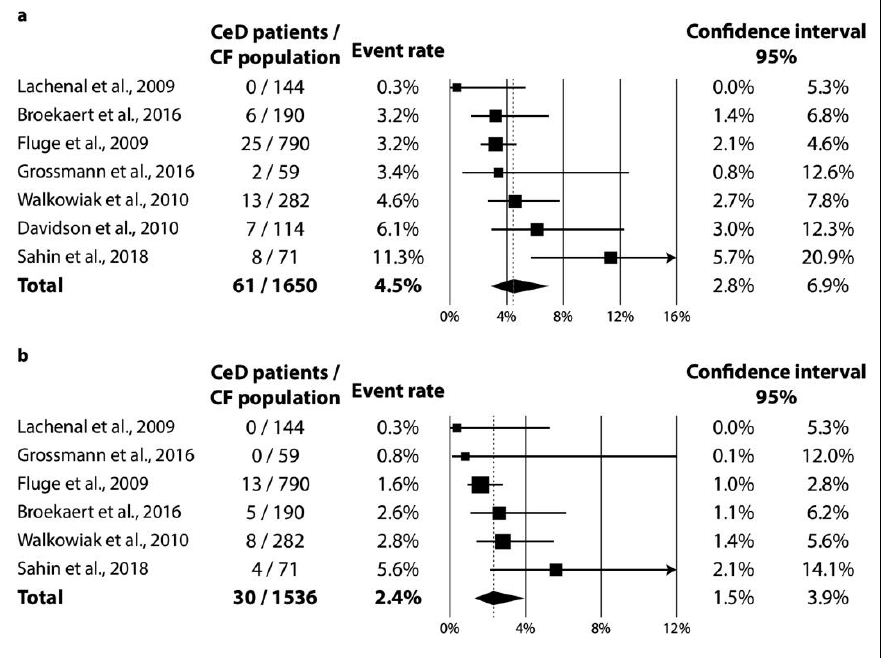
Figure 2. Seroprevalence of CeD: ( a ) TGA-IgA positivity; ( b ) TGA-IgA+EMA-IgA double positivity (CeD: celiac disease, CF: cystic fibrosis).